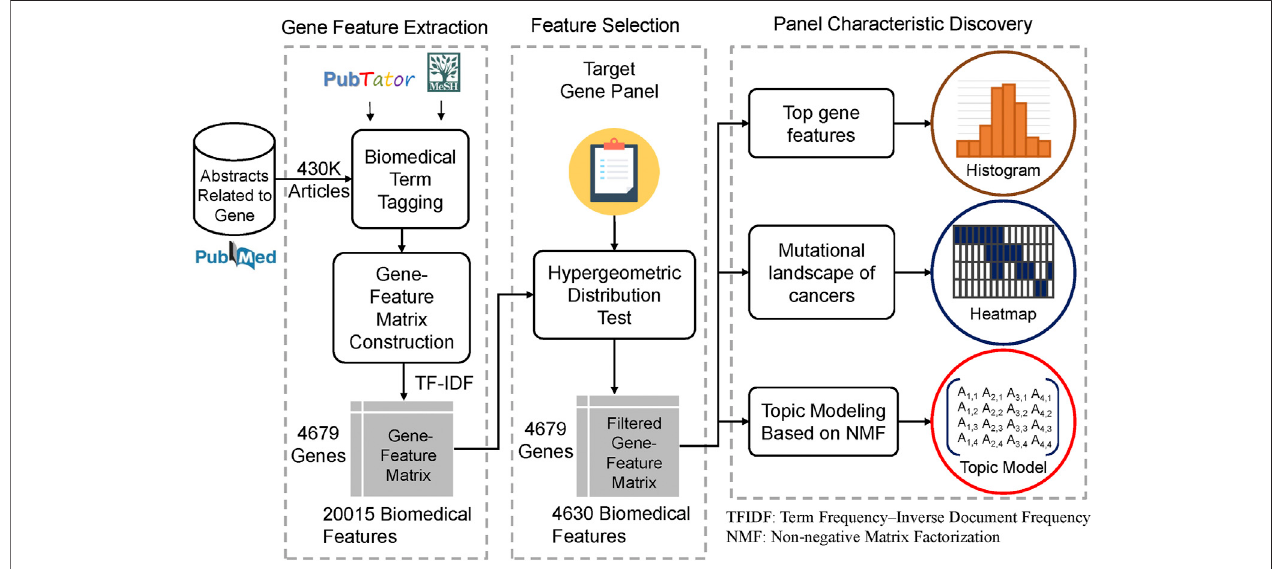
FIGURE 1 | Study design and work fl ow The fl owchart shows the overall analysis framework of this study. We fi rst extracted 430,000 abstracts that mentioned genes related to humans in the PubMed corpus. Second, biomedical named entity recognition (NER) was performed to obtain biomedical terms, such as gene name, disease name, and drug name, using PubTator and MeSH. Third, we used the biomedical term tagged by the previous step to construct the gene term-feature matrix whose concept was similar to the document-term matrix. Fourth, we performed term feature selection according to a particular gene panel. We took the MSK- IMPACT panel as an example and made the term features generated by the previous step correspond more to the target gene panel using the hypergeometric distribution. Finally, several analyses, including identifying the top gene term features, creating the mutational landscape of cancers, and topic modeling based on nonnegative matrix factorization, were conducted to determine and interpret the biomedical characteristics of the target gene panel.